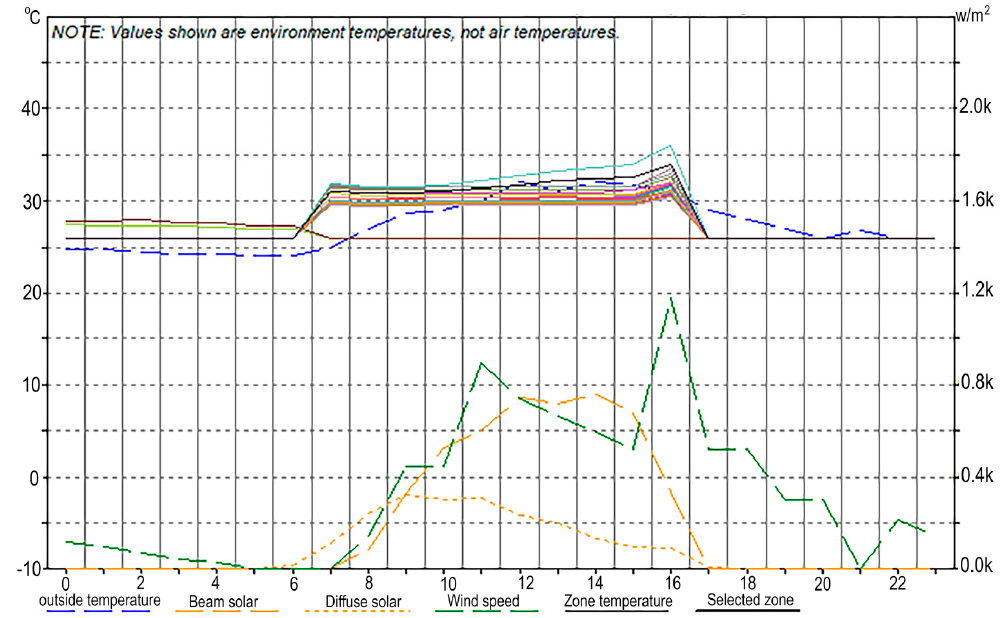
Figure 7. Average daily hourly temperatures in the study area.